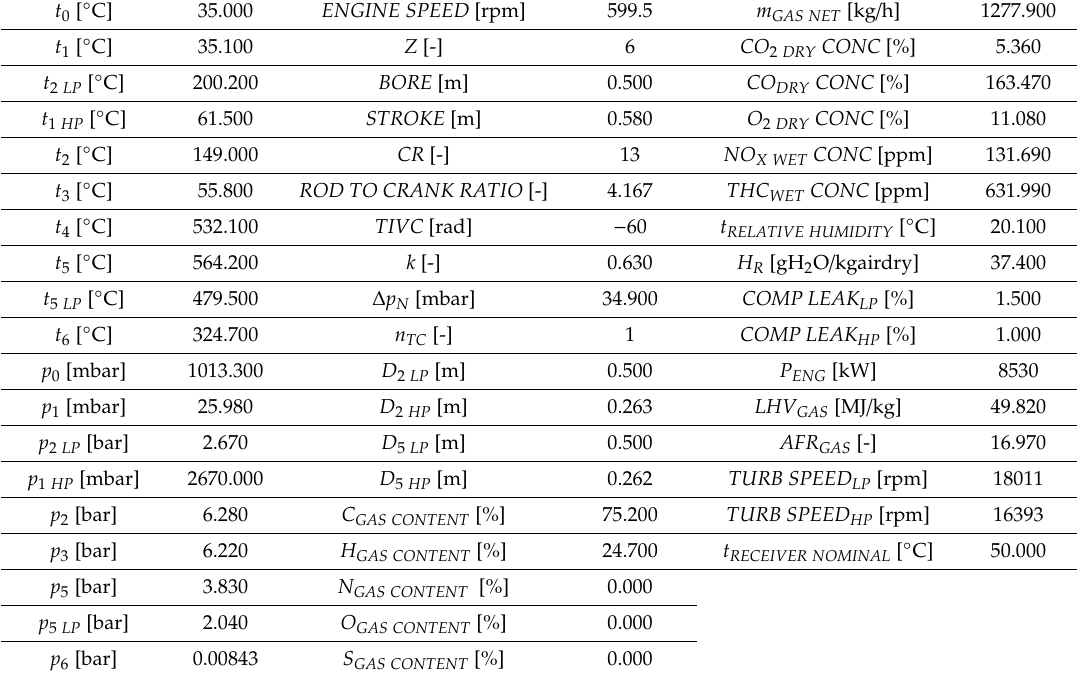
Table 5. Input values.